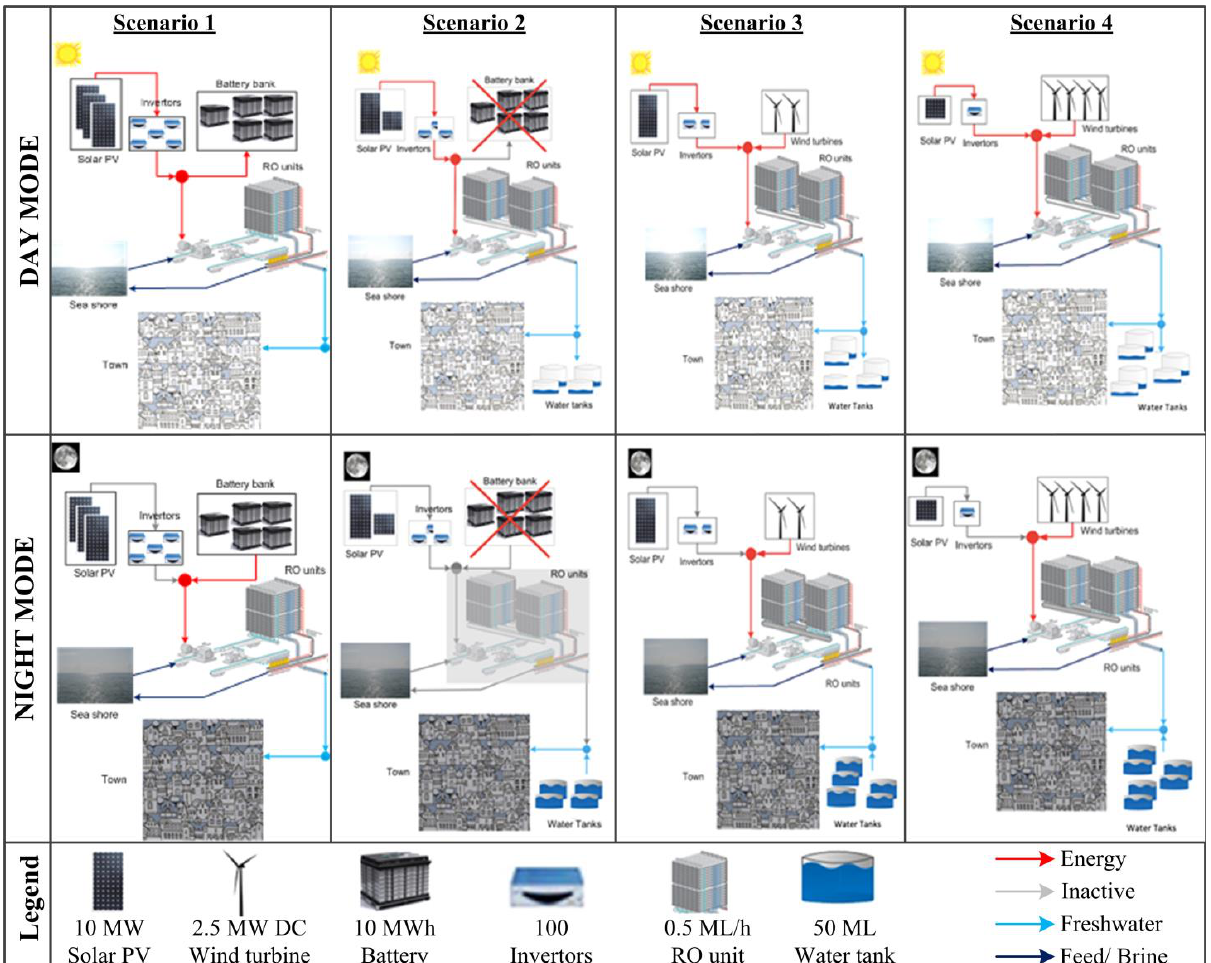
Figure 6. Illustrations of the day and night operation for each scenario. The capacity/size of each unit is demonstrated as in the legend (i.e., five tanks in Scenario 3 equal to 250 ML capacity).